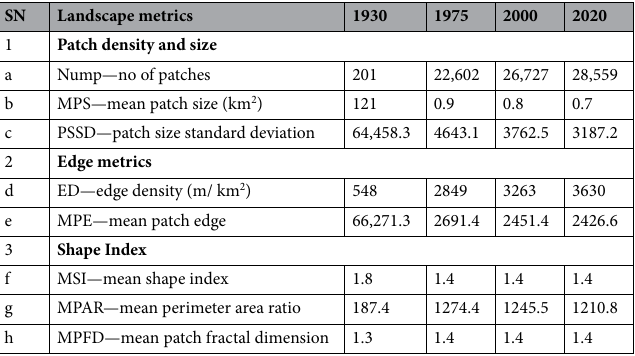
Table 2. Forest fragmentation status in the CTML, Nepal in different time periods.